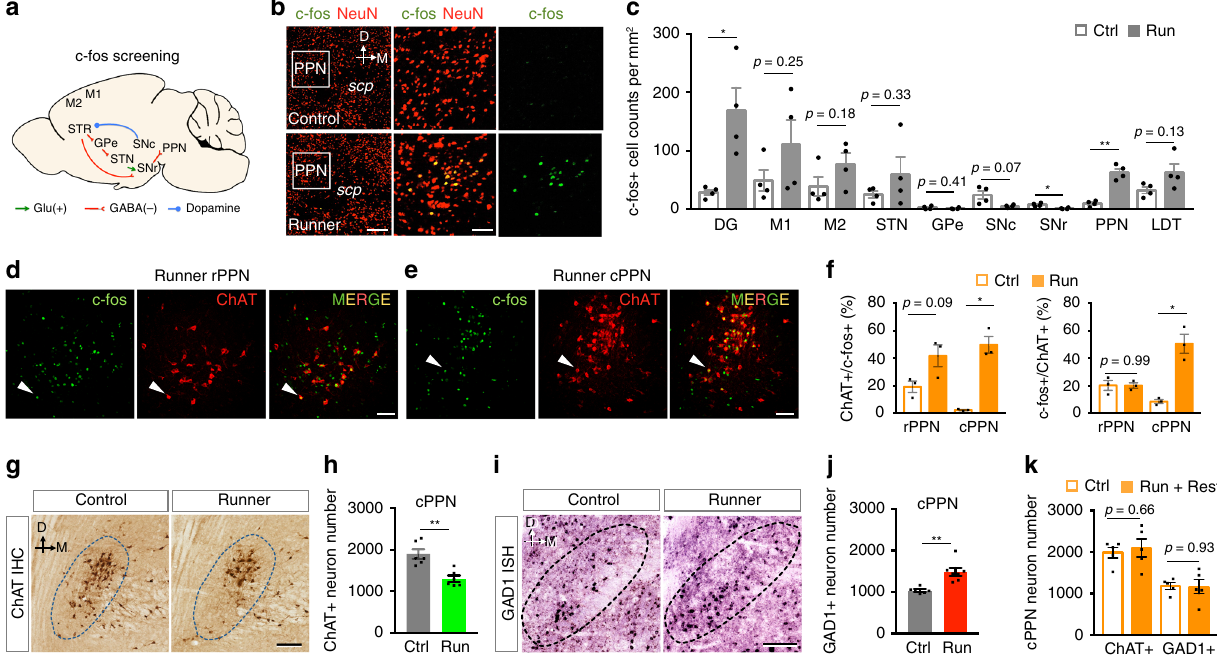
Fig. 2 Running activates the pedunculopontine nucleus (PPN) and triggers neurotransmitter switching in the caudal PPN. a Motor circuitry screened for activity. b Double staining of neuronal marker NeuN and activity marker c-fos in a control (upper) and 1-week runner (lower). Middle and right panels are higher magni fi cations of the boxes in the left panels. Scp, superior cerebellar peduncle. Dorsal (D) and medial (M) axes are shown at top. Scale bar, (left) 200 μ m, (middle) 50 μ m. c c-fos immunoreactive neuron number in each region or nucleus of controls and 1-week runner mice. DG, dentate gyrus; M1, primary motor cortex; M2, secondary motor cortex; STN, subthalamic nucleus; GPe, globus pallidus external; STR, striatum; SNc, substantia nigra pars compacta; SNr, substantia nigra pars reticulata; PPN, pedunculopontine nucleus; LDT, laterodorsal tegmental nucleus. For b , c , n = 12 sections from 4 animals per group. d , e Double staining of ChAT and c-fos in the rostral ( d ) or caudal ( e ) PPN of a 1-week runner. White arrowheads identify examples of c- fos + ChAT + cells. Scale bar, 100 μ m. f Percentage of the c-fos + ChAT + neurons in the total ChAT + neurons (left) or in the total c-fos + neurons (right). For d – f , n = 3 animals per group . g 3,3 ′ -diaminobenzidine (DAB) staining of ChAT in the cPPNs of a control and 1-week runner. Dotted lines outline the PPN. Dark brown stain identi fi es ChAT + neurons. Scale bar, 100 μ m. h Stereological counts of g . n = 6 animals per group. i In situ hybridization of GAD1 in the cPPN of a control and 1-week runner. Scale bar, 100 μ m. j Stereological counts of i . n = 7 animals per group. k Stereological counts of ChAT + or GAD1 + neurons in the cPPN of mice that experienced 1 week of running followed by 1 week of rest and of control mice that never ran on a running wheel. n = 5 animals per group. Statistical signi fi cance * p < 0.05, ** p < 0.01 was assessed by two-sided Welch ’ s t -test ( c , f ) or Mann – Whitney U test (other panels). Data shown are mean ±